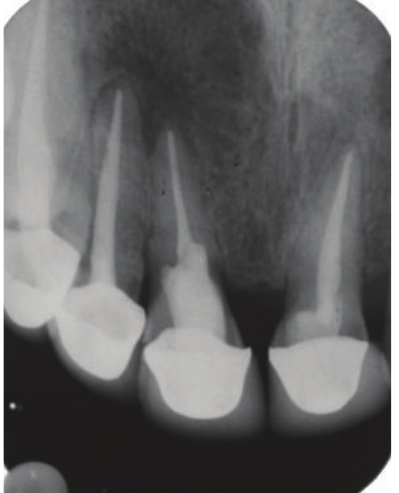
Figure 22: 18-month followup IOPA radiograph.